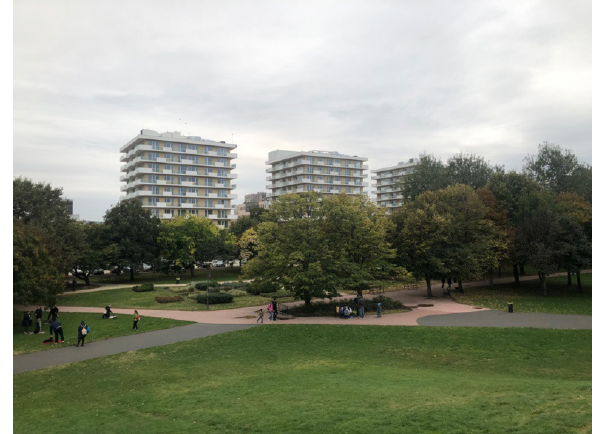
Figure 4. Use and reuse of the ground floor in panel buildings the “legs” residential buildings from the 80’s (source: author)